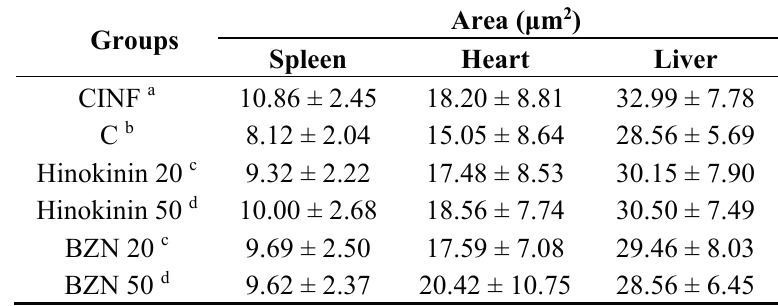
Table 4. Karyometry analysis. Mean values of the nuclear area from cells of the spleen, liver, and heart of control groups and mice inoculated with the CL Brener clone strain of Trypanosoma cruzi B5.